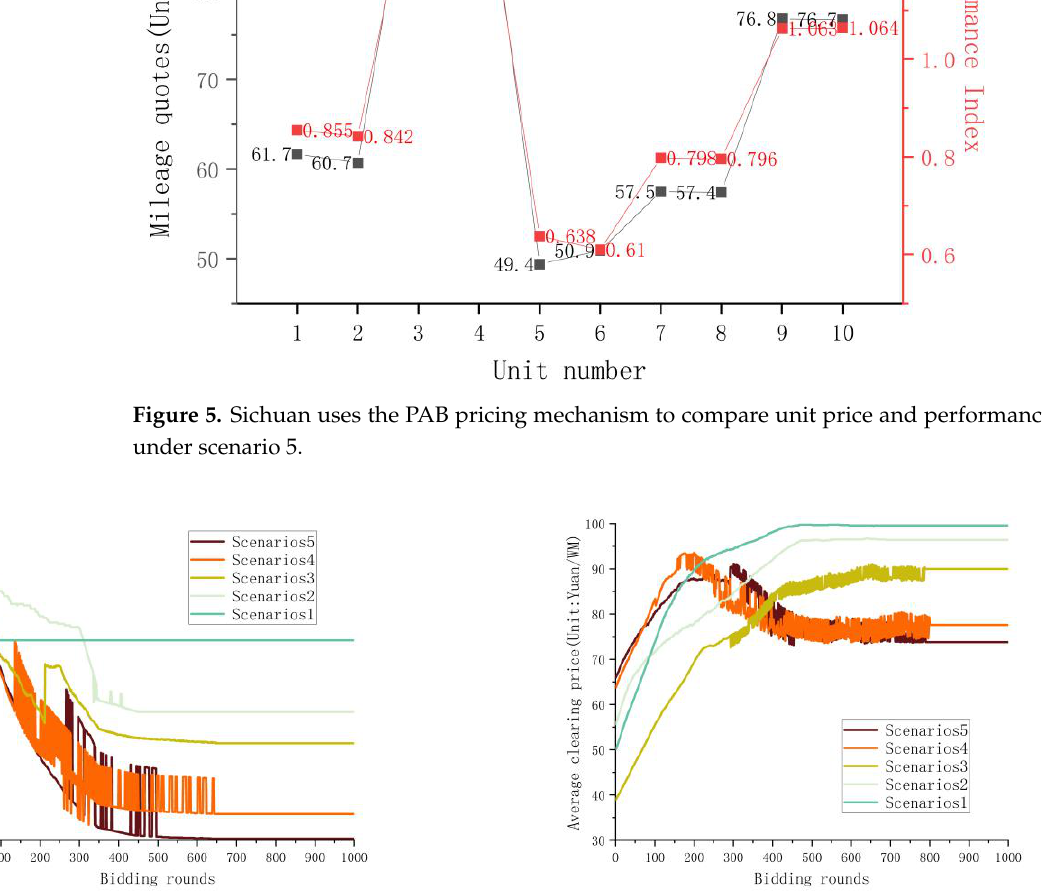
Figure 6. Evolution of market clearing prices when MCP ( a ) and PAB ( b ) are adopted in Sichuan.